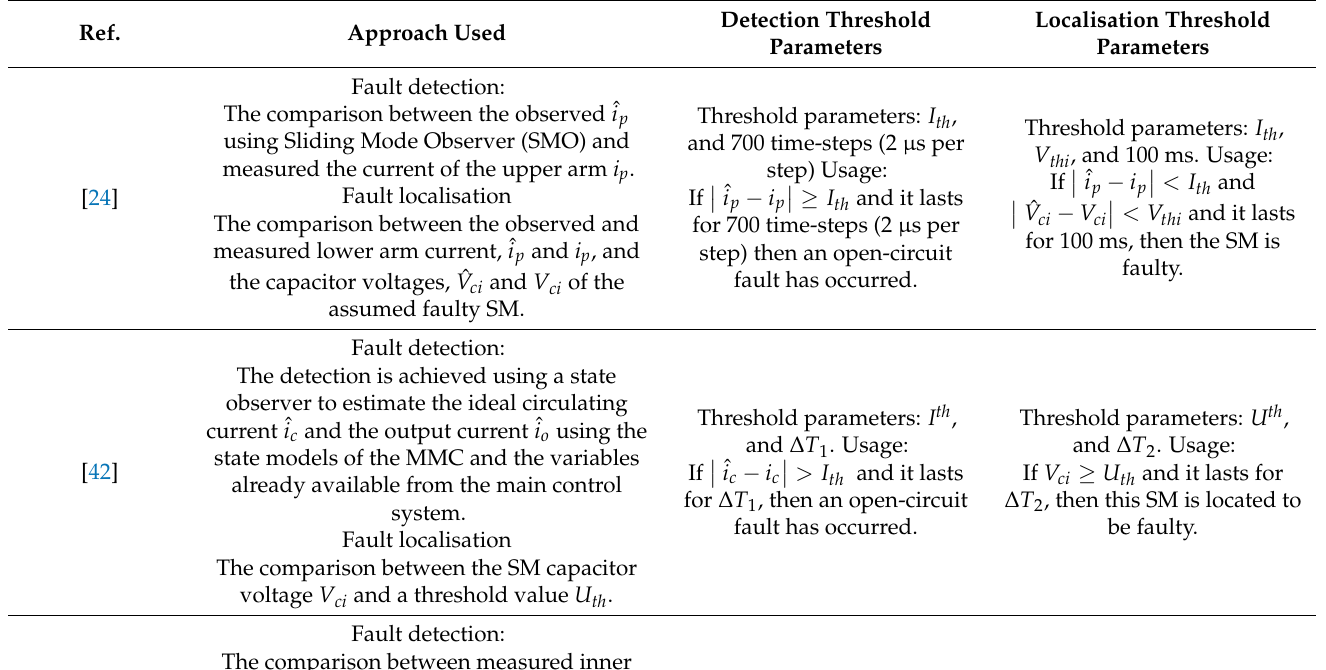
Table 1. Summary of different techniques that have been used in different studies of IGBT open-circuit fault